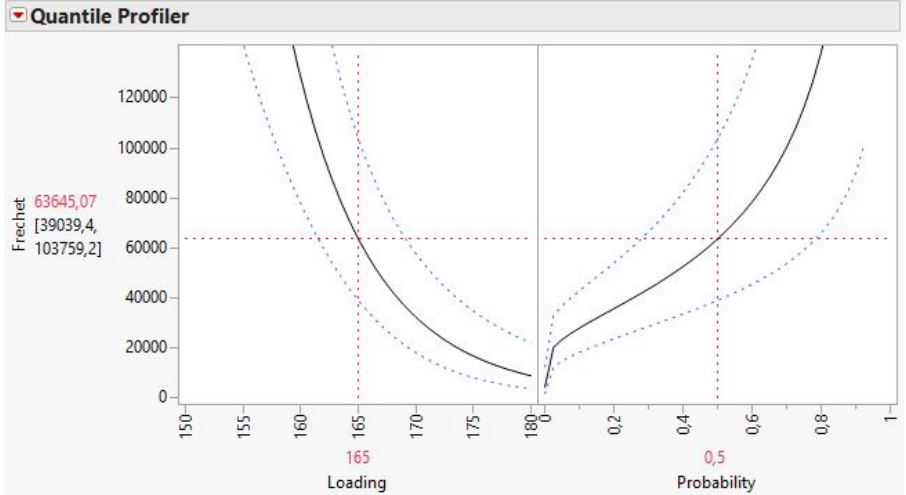
Figure 8. Quantile analysis for Material#2.